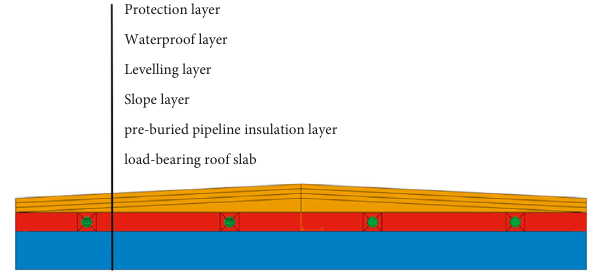
Figure 2: Schematic of the main roof